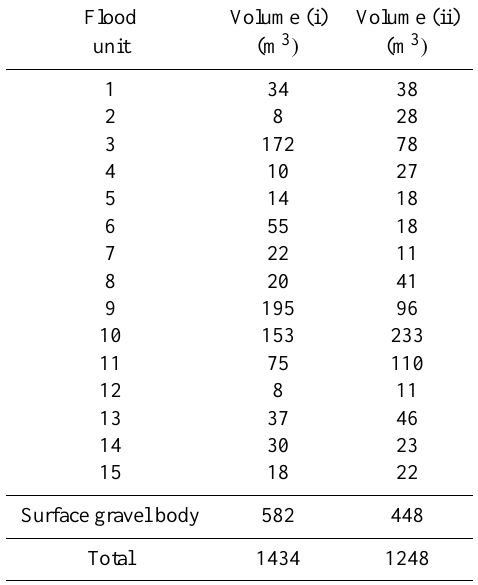
Table 2. Flood unit volumes, calculated by two tech- niques: (i) “wedge” approach: every layer volume was calculated as if each flood unit had a pyramidal shape (such as a wedge); (ii) pro- portional approach: by subtracting from the actual deposits the average accumulated layer depth, considering the thickness differ- ence of each layer in each trench and approaching it as a pyramidal shape. The “surface gravel body” layer represents the sedimentation produced by multiple events without clear stratigraphic contacts.